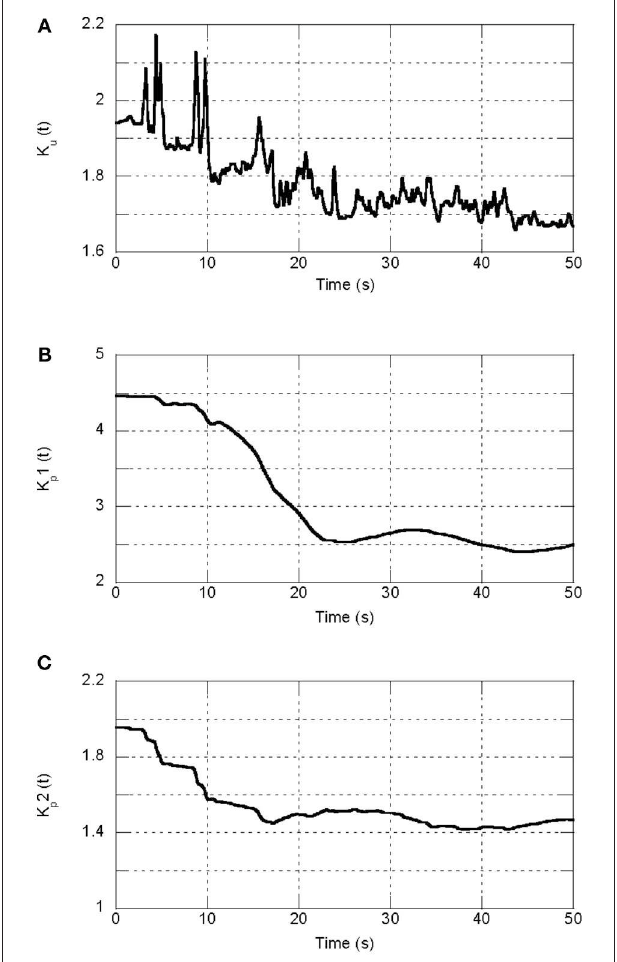
FIGURE 9 | Adjustment of MRAC controller parameters for the Taft earthquake. (A) Adjustment of K u [ e y ( t ) , t ] . (B,C) Adjustment of K p [ e y ( t ) , t ]